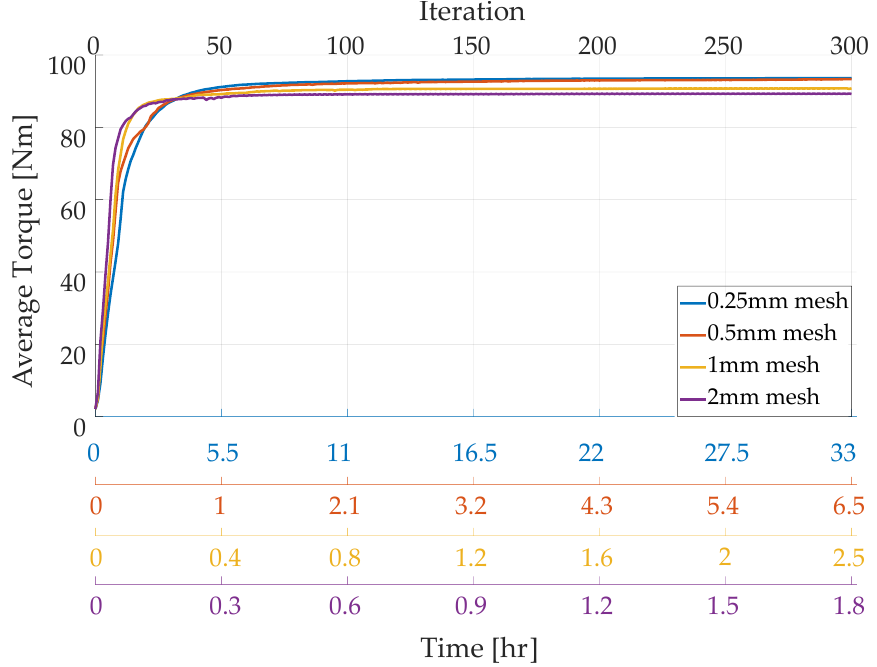
Figure 4. Results of optimizations with different mesh densities. The maximum objective values were obtained as 97.5, 97.2, 94.7 and 93.2 Nm for decreasing mesh intensity. This suggests that with the increased mesh resolution, it is possible to obtain slightly better average torque by compromising the computation